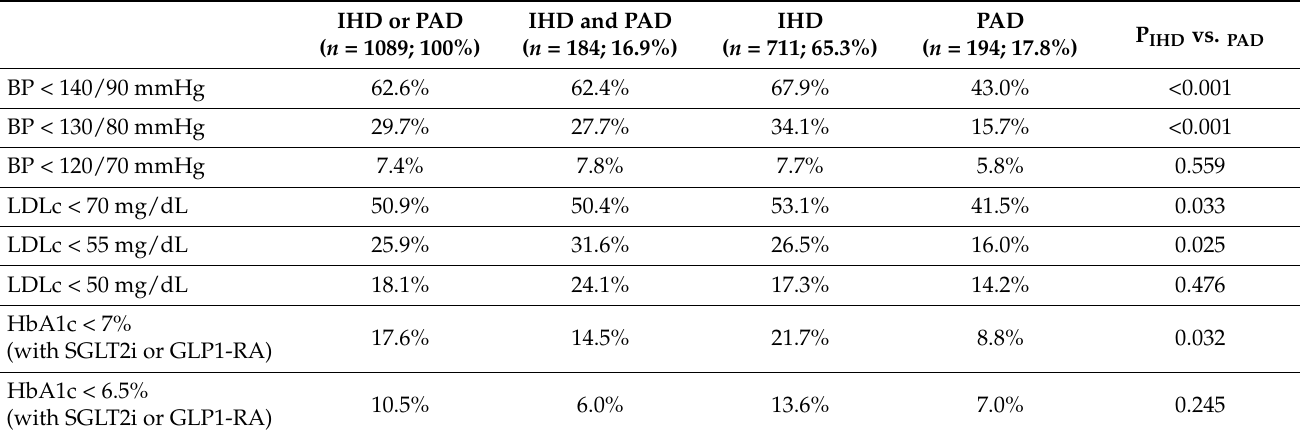
Table 4. Proportion of patients achieving cardiovascular risk factor